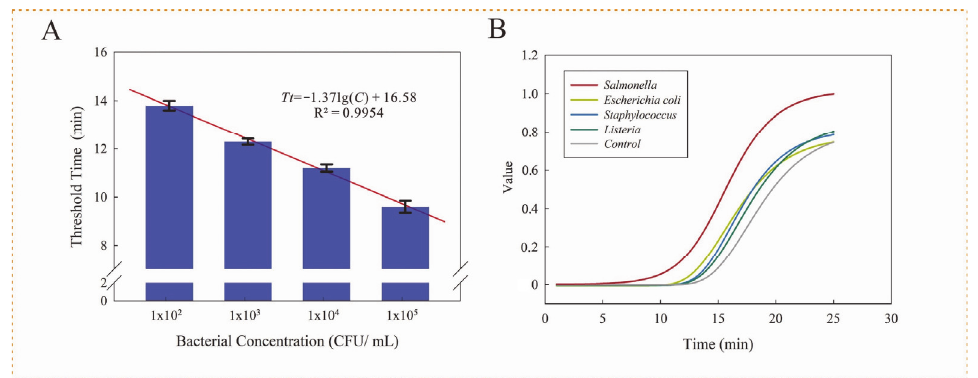
Figure 4. Performance of this microfluidic chip. ( A ) The linear relationship between the threshold time and the bacterial concentration (N = 3). ( B ) The specificity of this microfluidic chip. Table 2. The recovery of the spiked Salmonella